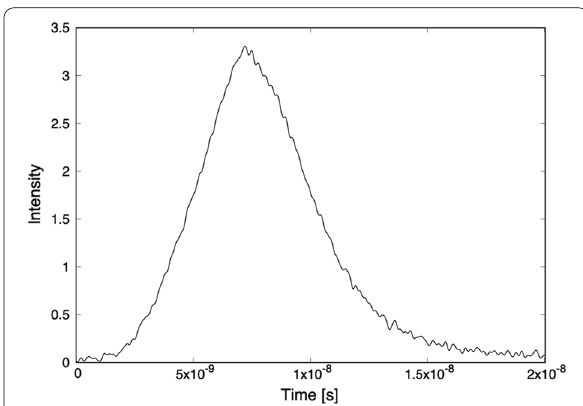
Fig. 2 Example of a normalized transmitted laser waveform, τ( t ) . The vertical axis is arbitrary